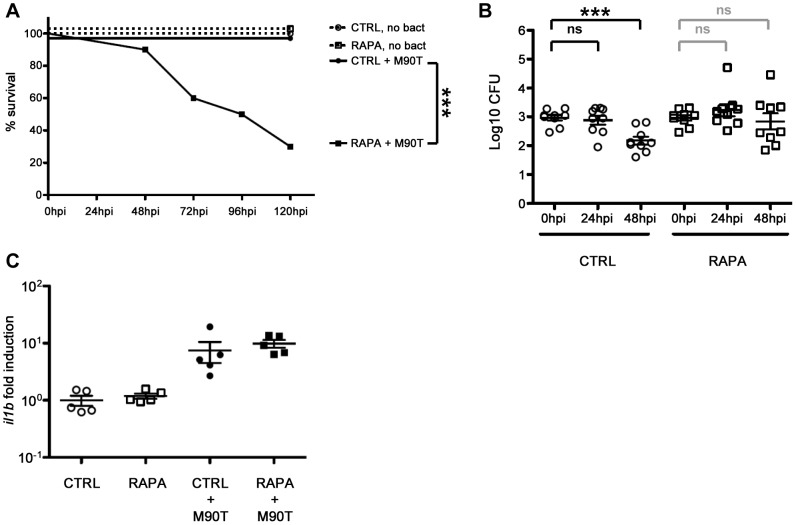

In vivo perturbation of autophagy via rapamycin stimulation.A. Survival curves of zebrafish larvae treated with control (CTRL) or rapamycin (RAPA) and infected with a sublethal dose of S. flexneri (+M90T) or not infected (no bact). Representative experiment of at least 3 independent ones; n = 10 or more larvae per group. Significance testing performed by Log Rank test. ***, P = 0.001. B. Bacterial counts in zebrafish larvae treated with control (CTRL) or rapamycin (RAPA) and infected with a sublethal dose of S. flexneri. Enumeration of live bacteria in homogenates from individual larvae at various times postinfection measured by plating onto LB. CTRL larvae = open circles. RAPA-treated larvae = open squares. n = 3 larvae per treatment, pooling of 3 independent experiments. Of note, dead larvae at 24 or 48 hpi (overwhelmed with bacteria, as determined by fluorescence stereomicroscopy) were not included here, and only larvae having survived the infection (thus far) were included here (and in this case, statistics are in grey). Mean±SEM also shown (horizontal bars). Significance testing performed by Student's t test. ns, P>0.05; ***, P<0.001. C. Inflammatory response is not affected in rapamycin-treated larvae. Expression of il1b transcripts at 96 hpf in larvae injected with ∼103
S. flexneri at 72 hpf (+M90T) or in uninfected controls, treated after infection with rapamycin (RAPA) or vehicle only (DMSO, i.e., CTRL). Il1b/ef1α transcript number ratios, normalized to the mean value in uninfected controls. Results for 5 pools of 3 larvae per group, mean±SEM also shown (horizontal bars).